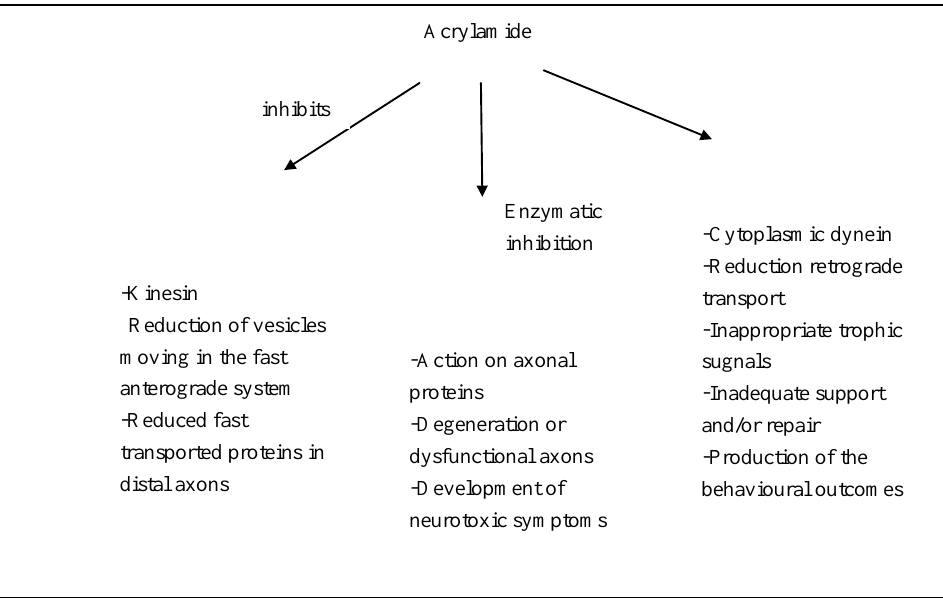
Figure 1. Model of ACR action leading to neurotoxicity.